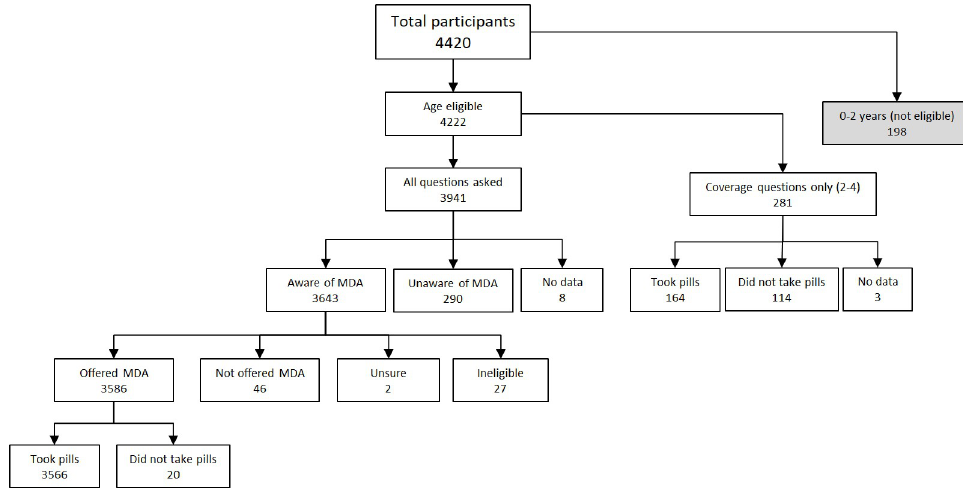
Fig 3. Study participant